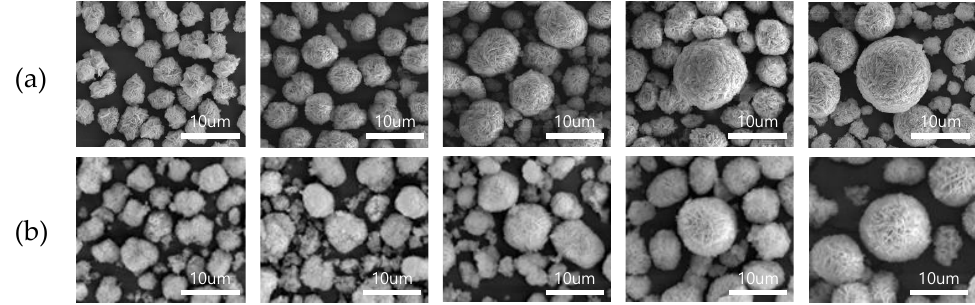
Figure 3. SEM images of the precursors of ( a ) pristine NCM and ( b ) NCMS according to the co- precipitation time (( a ) 16, 24, 40, 64, and 72 h, ( b ) 5, 26, 40, 64, and 75 h).